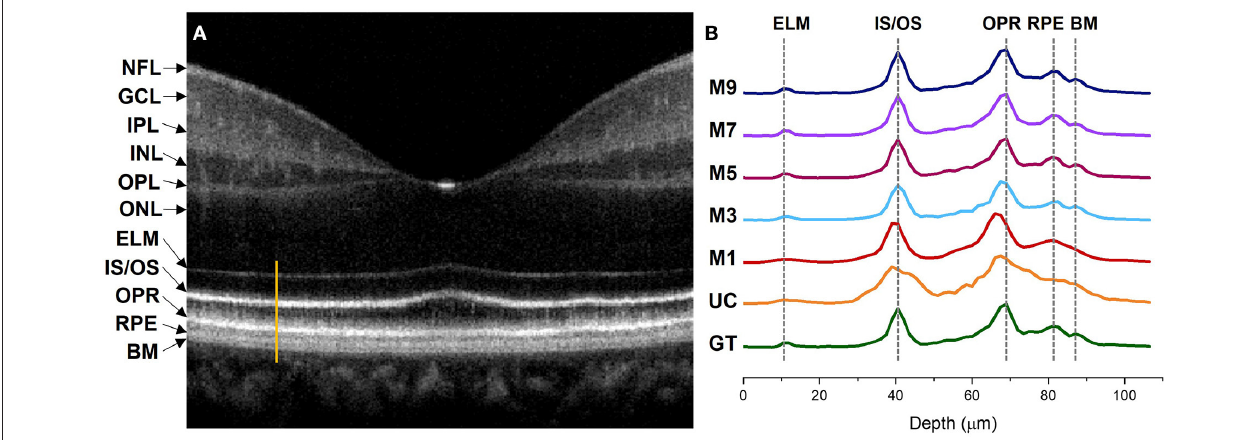
FIGURE 5 | Intensity profile analysis of the outer retinal bands. (A) OCT B-scan of a human retina at the macula region with different retinal layers labeled accordingly. The bright orange line represents the A-line segment of the outer retina at the parafovea region where the intensity profiles in (B) were computed. (B) Intensity profiles generated from different image models. GT, ground truth; UC, uncompensated; M1, single input channel; M3, three input channels; M5, five input channels; M7, seven input channels; M9, nine input channels; NFL, nerve fiber layer; GCL, ganglion cell layer; IPL, inner plexiform layer; INL, inner nuclear layer; OPL, outer plexiform layer; INL, outer nuclear layer; ELM, external limiting membrane; IS/OS, inner segment/outer segment junction; OPR, outer plexiform layer; RPE, retinal pigment epithelium; BM, bruch’s